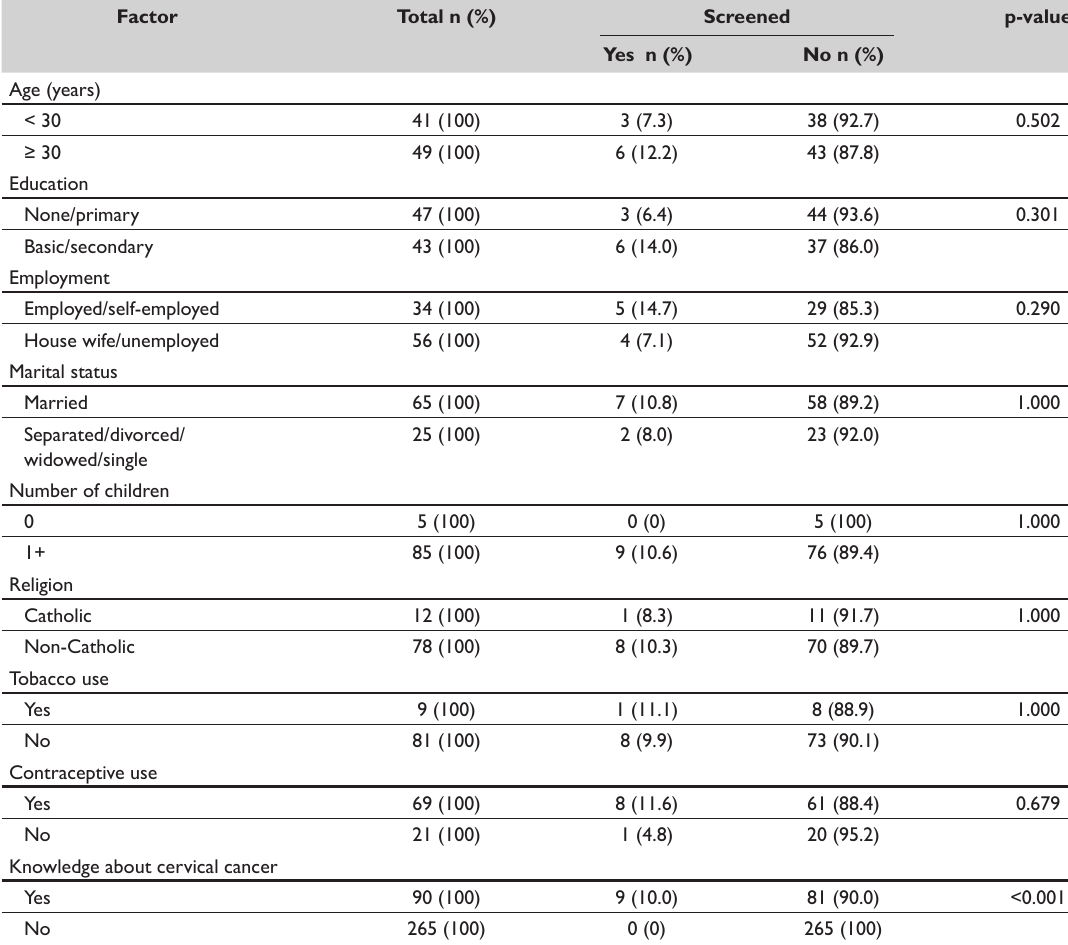
Table 2: Demographic, contraceptive use, knowledge about cervical cancer and tobacco use factors associated with cervical cancer